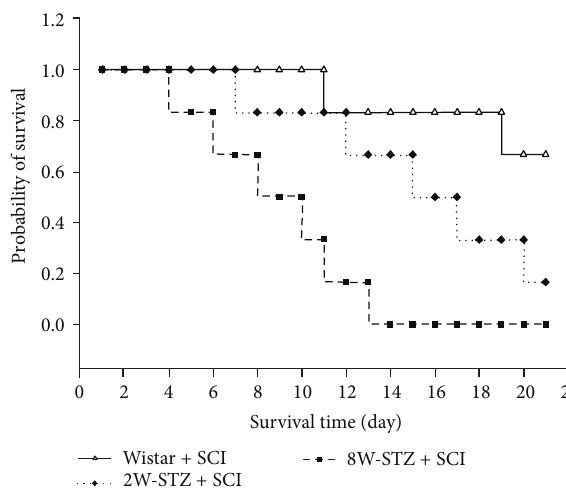
Figure 1: The effect of SCI on survival ability in STZ-diabetic rats. STZ-diabeticratswereobtainedfromthetwo-weekinductiongroup (2W-STZ) and the eight-week induction group (8W-STZ). Data represent the survival rate of ten animals in each